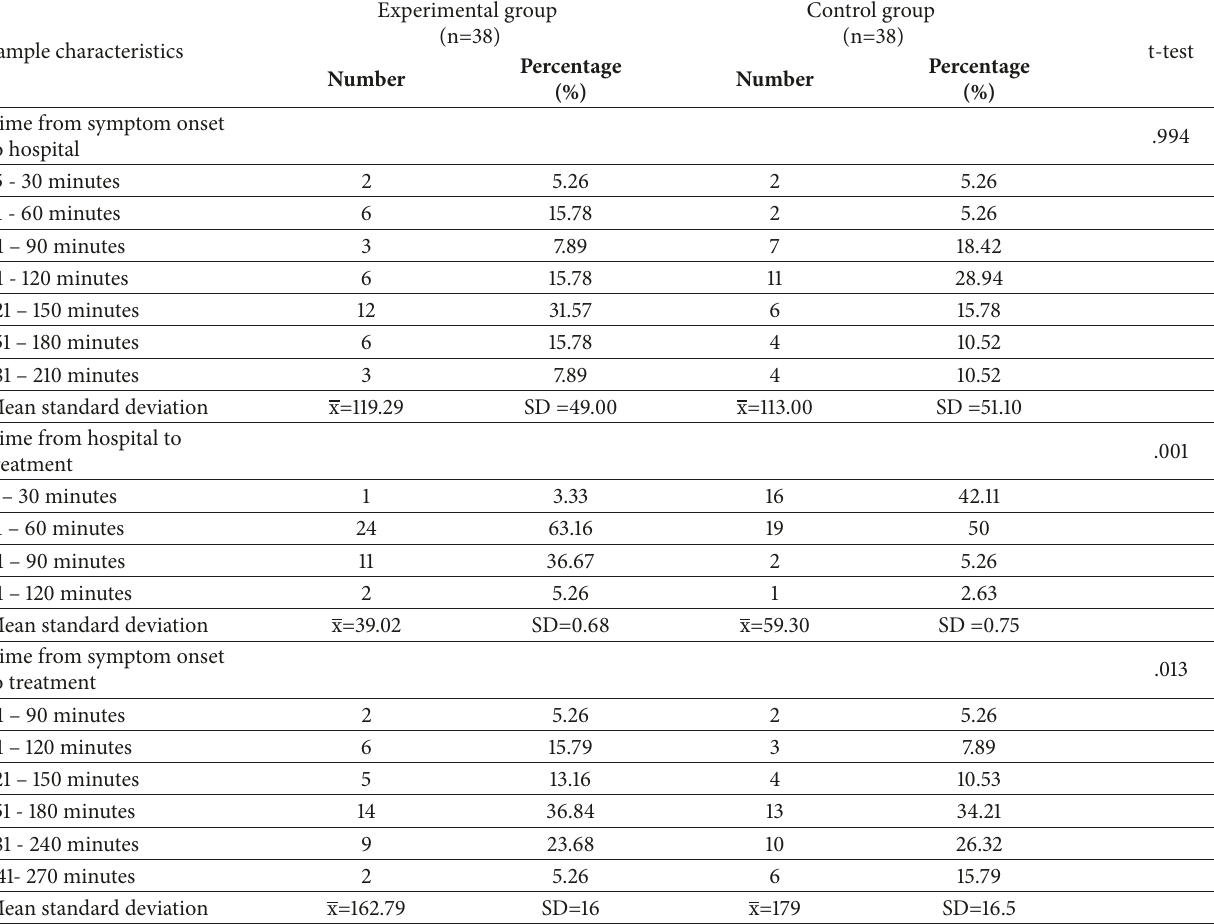
Table 3: The parameters of time from symptom onset to hospital, time from hospital to received rt-PA, and time from onset to received rt-PA were compared between experimental and control groups.